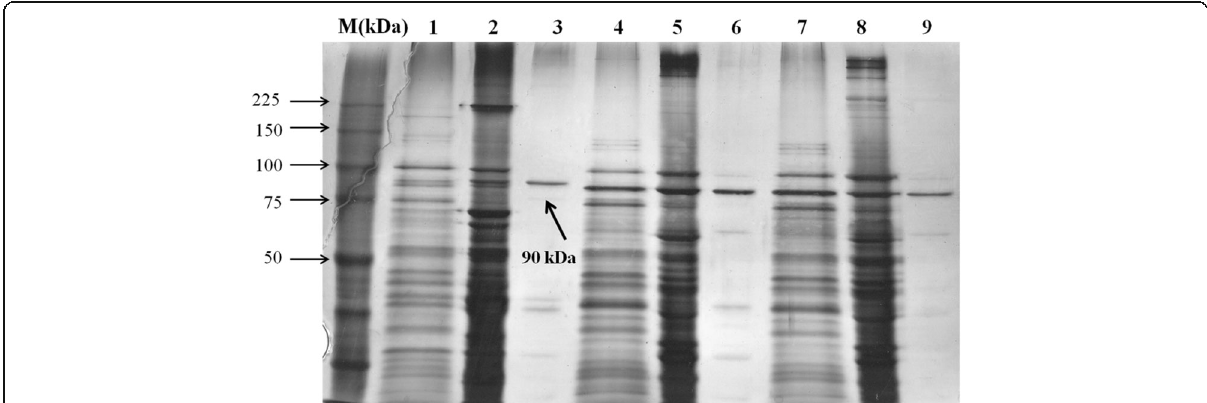
Fig. 2 SDS-PAGE analysis of partially purified Vip3 proteins from Bacillus thuringiensis isolates. 1, 4, and 7 indicate crude extract of HD-1 as positive control, BnBt, and MnD strains. 2, 5, and 8 indicate 60% ammonium sulfate precipitation of HD-1, BnBt, and MnD supernatants. 3, 6, and 9 indicate ion-exchange column chromatography